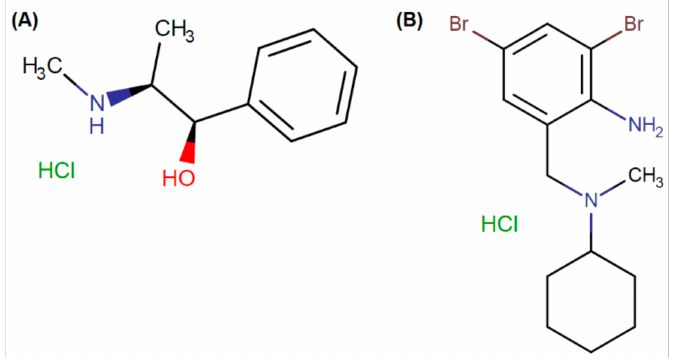
Figure 2. Chemical structures of ( A ) EH and ( B )